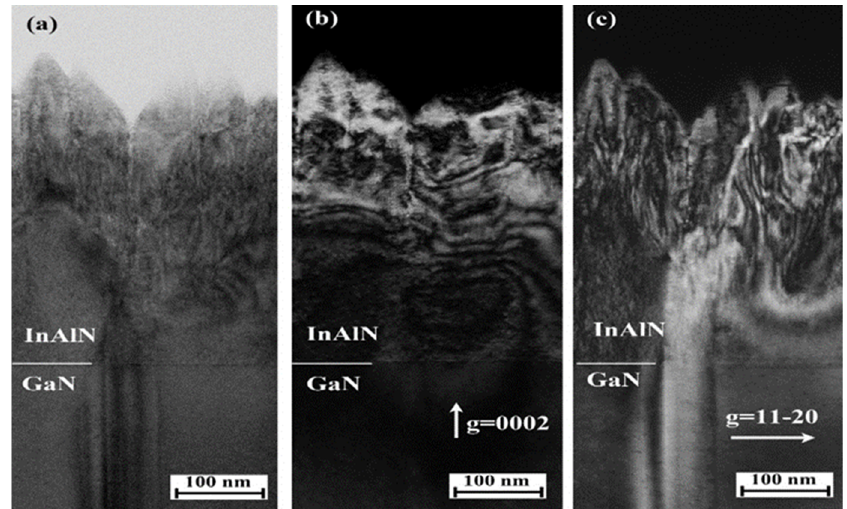
Figure 3. Cross-section TEM dark-field images of the 450 nm-thick InAlN epilayer with ( a ) bright-field images with g = [112 (cid:3364) 0], ( b ) g = [0002], and ( c ) g = [112 (cid:3364) 0].